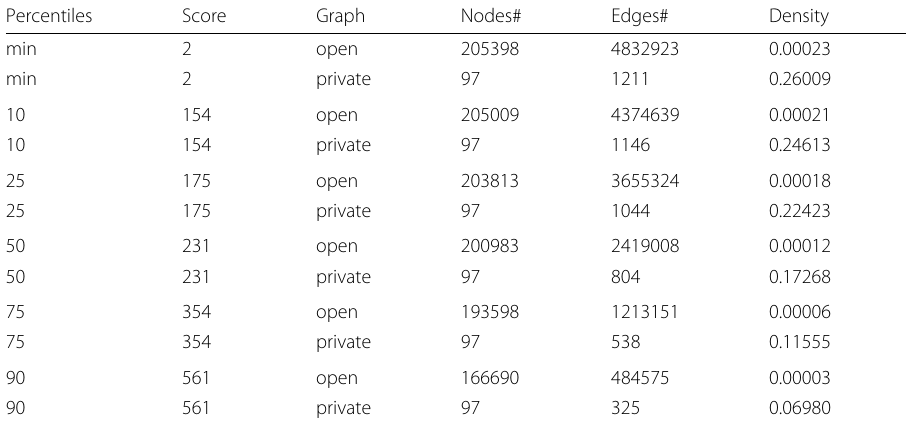
Table 19 Global measures values of the metabolites networks extracted from the STITCH database and the private networks according to combined score percentiles Percentiles Score Graph Nodes#